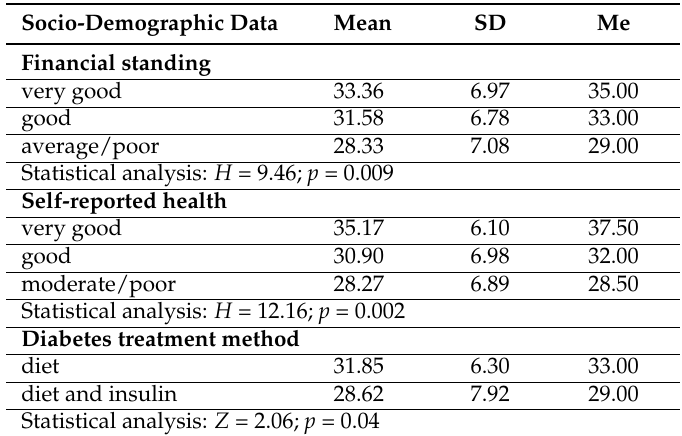
Table 6. AIS scores in relation to socio-demographic data and various aspects of life. Socio-Demographic Data